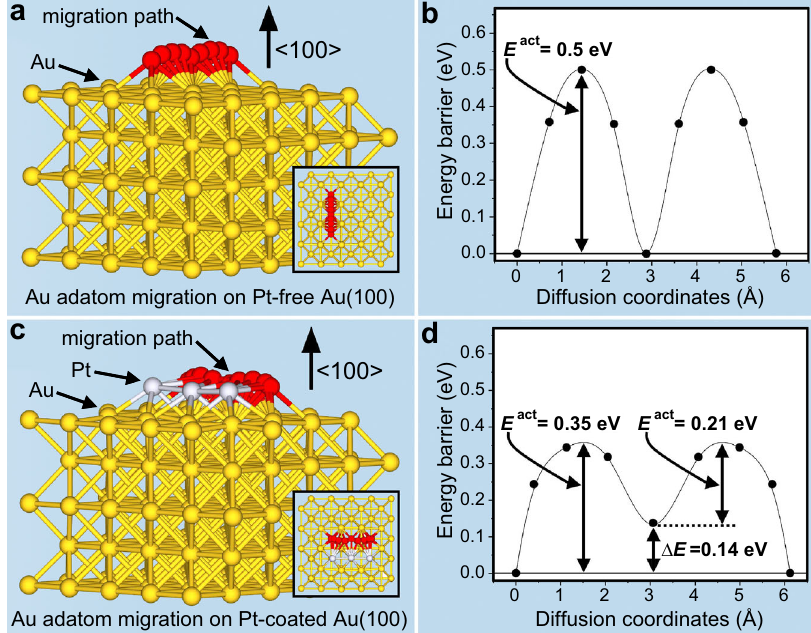
Fig. 1 DFT study and schematic adatom migration. a , b Au adatom migration on Pt-free Au(100) surface, c , d Au adatom migration on Pt-coated Au(100). The insets in a and c are top view of adsorbate